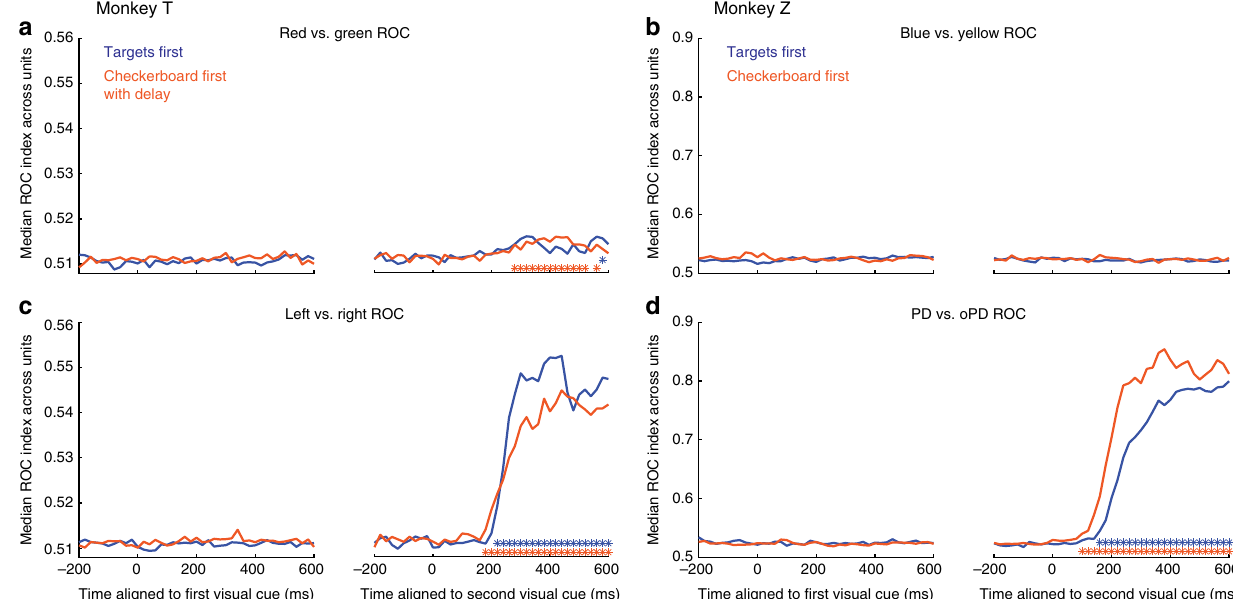
Fig. 6 Identifying color selectivity and reach direction selectivity. Receiver operating characteristic (ROC) analysis was performed on the single-trial discharge rates for each unit at every 20 ms time point from − 200 ms before to + 600 ms after the appearance of the fi rst (left of each pair of fi gures) and second (right) visual cue in each trial, for trials sorted according to the dominant color of the checkerboard ( a , b ) or the chosen direction of reach ( c , d ) in the TF (blue) and CFD/CF (orange) tasks. The median area-under-the-ROC-curve (AUC) value across the population of units is plotted at each 20 ms time point. The median AUC values for the Color test were very small at all times in both tasks in both monkeys ( a , b ), indicating a very weak representation of information about the dominant color of the checkerboards. In contrast, there was an abrupt increase in median AUC values for Direction shortly after the appearance of the second visual cue in both tasks in both monkeys ( c , d ). As in previous directional analyses, the direction-related ROC values were larger in Z than in T. To detect a signi fi cant increase in the detectability of color or direction information in the population activity, the distribution of AUC values measured in each 20 ms time step was compared to a baseline 20 ms interval − 200 ms before the appearance of the fi rst visual cue (one-tailed Wilcoxon signed-rank test, p < 0.01). Time steps in which the distribution of AUC values were signi fi cantly higher than the baseline distribution are indicated by blue and orange asterisks for the TF and CFD/CF tasks,